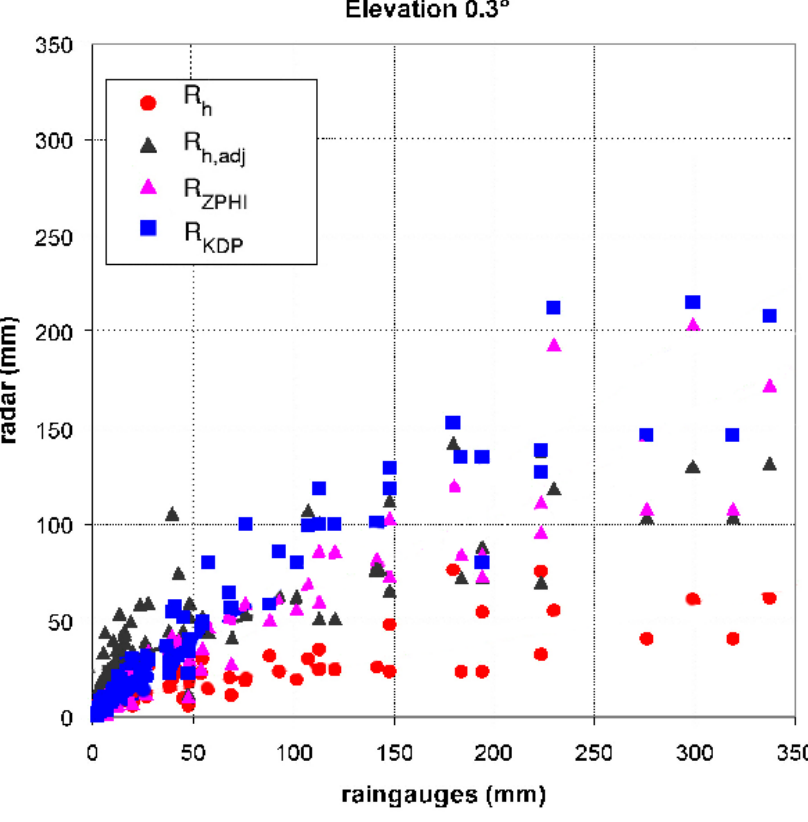
Figure 2. Rainfall accumulation since 00:00 UTC to 09:00 UTC on 16 August 2006 by radar and ground station location estimated by four algorithms.